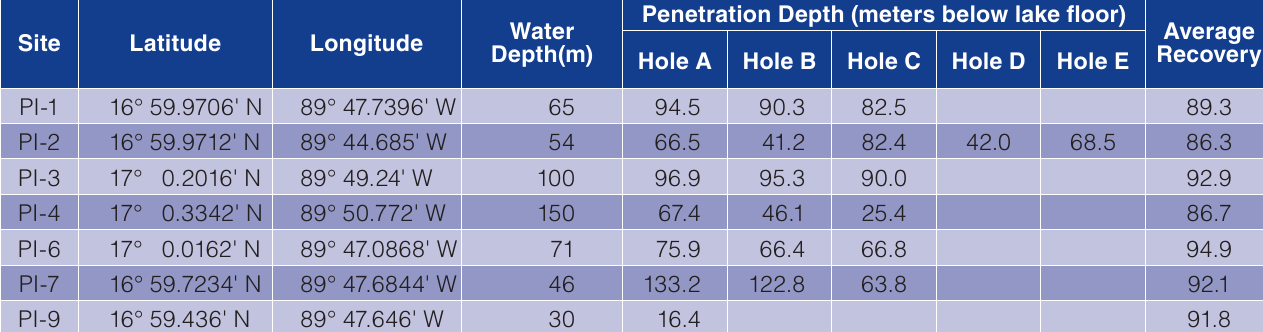
Table 1: Location of drilling sites, water depth, penetration, and core recovery at Lake Petén Itzá Site